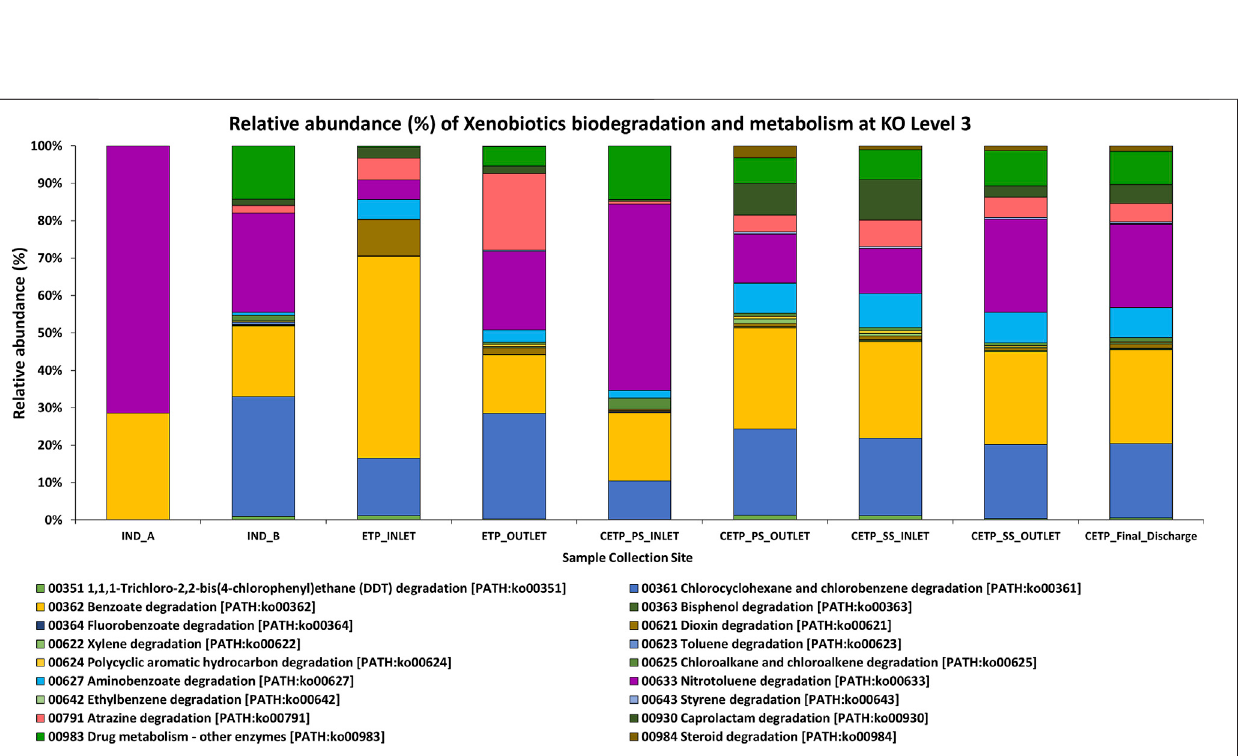
FIGURE 5 | Relative abundance of the xenobiotic degradation and metabolism at KO Level 3 (KO-3), highlighting the metabolic functions of the key pathways involved in the synthetic chemical degradation in the textile wastewater and industry ef fl uent treatment process. Samples from the industry ef fl uent sites (IND_A and IND_B) were dominated by nitrotoluene degradation and benzoate degradation. In the ETP sites, chlorocyclohexane and chlorobenzene degradation was found, while the aminobenzoate degradation pathways were dominant in the secondary treatment and fi nal discharge site.